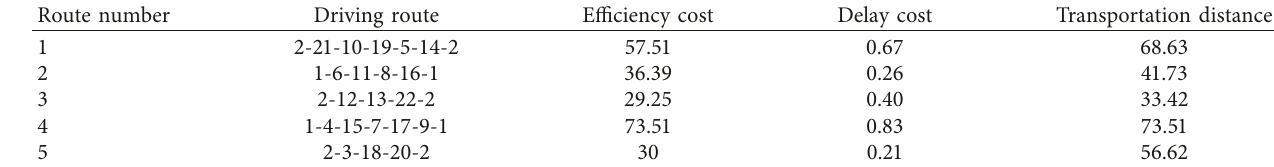
Table 6: Subpath transport route with all roads repaired.